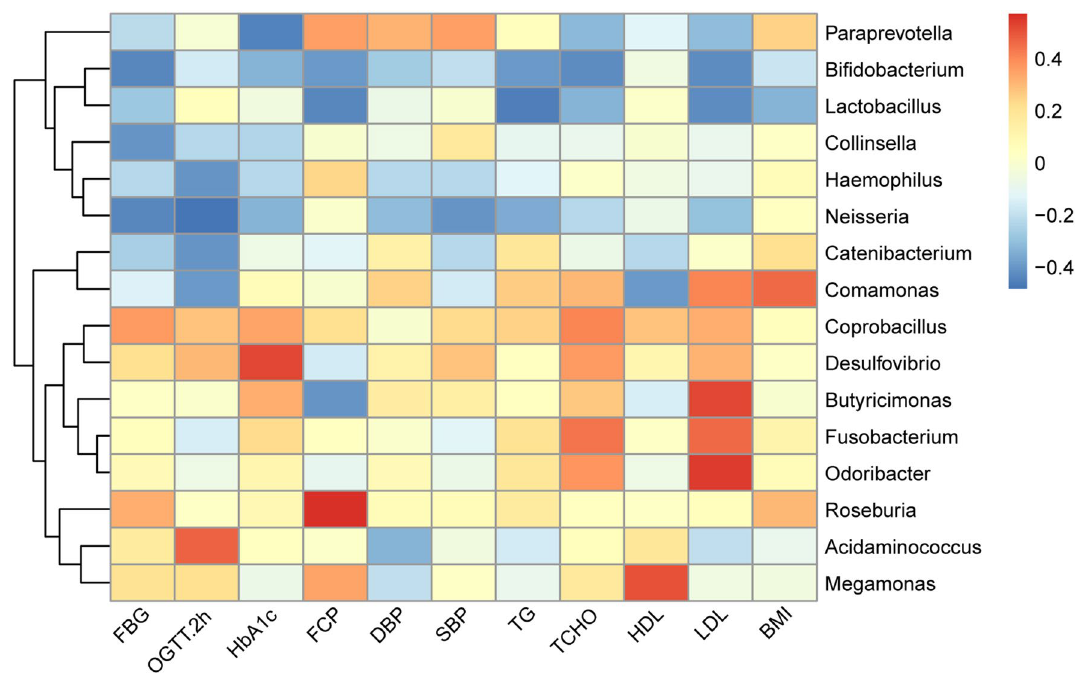
Figure 5. Heat map of identified key genus responding to the treatments and Spearman’s correlation between identified genus and biochemical indices. The color of the spots represents R-value of Spearman’s correlation between the genus and biochemical